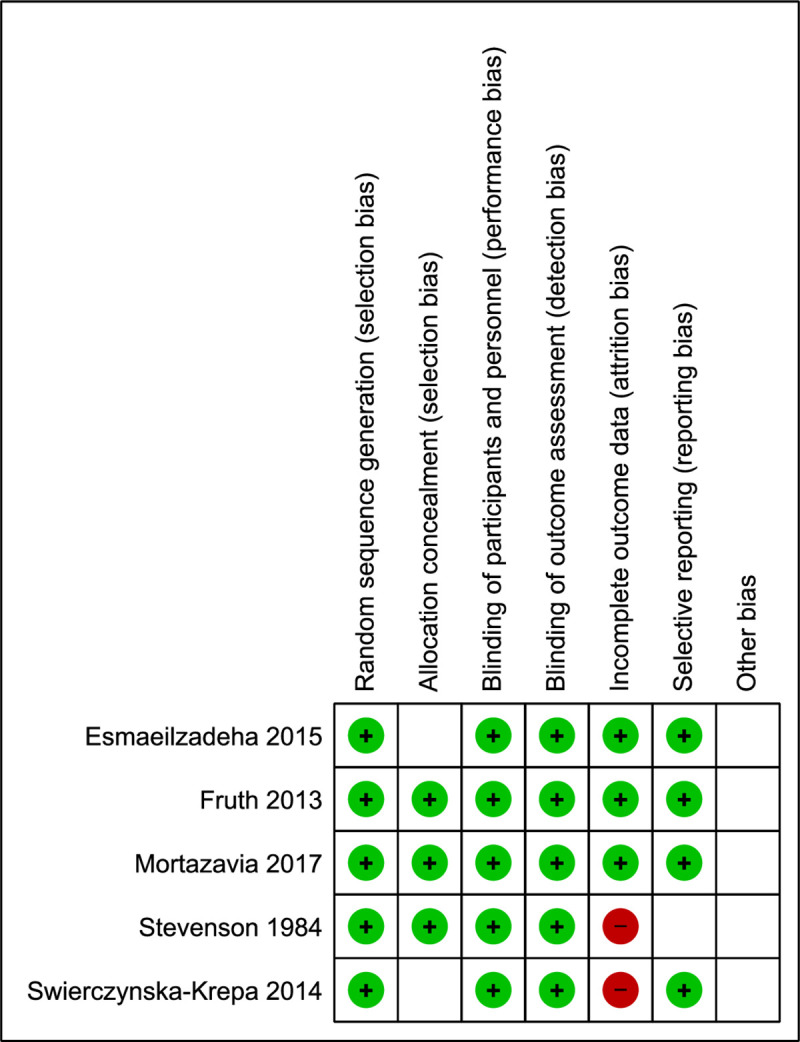
Risk of bias summary.